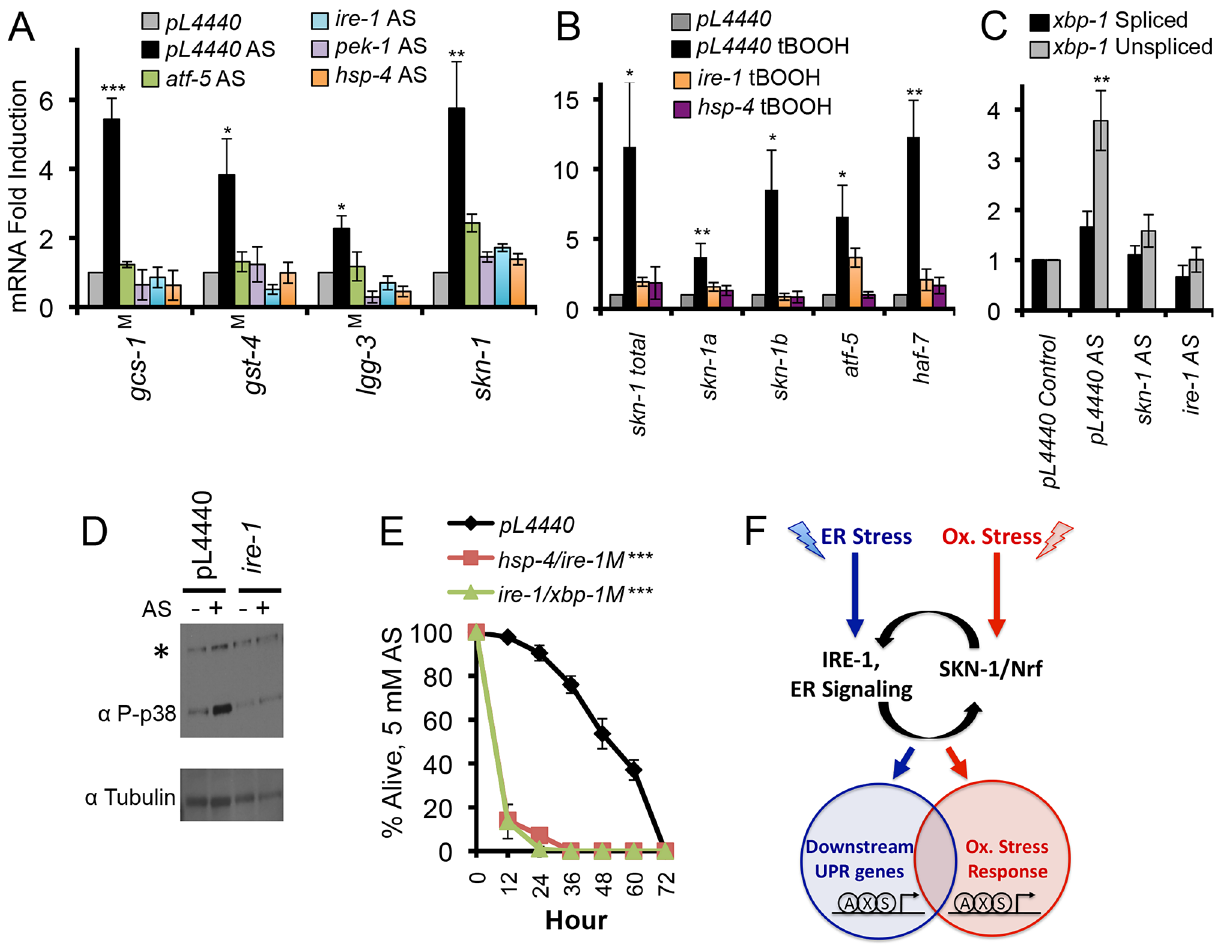
Figure 7. Dependence of oxidative stress responses on UPR components. (A, B) Importance of core UPR genes for SKN-1-mediated oxidative stress responses. Induction of skn-1 and skn-1 target gene transcription by AS (A) or t-BOOH (B) was impaired by RNAi against core UPR genes or in core UPR factor mutants (indicated by M ). qRT-PCR was performed after treatment with 5 mM AS for 1 hour, or 12 mM t-BOOH for 1 hour. (C) Accumulation of xbp-1 mRNA in response to AS-induced oxidative stress. Note the predominant increase in the unspliced form. (D) Dependence of AS-induced p38 phosphorylation on ire-1 . Phosphorylated (active) p38 was assayed by phospho-specific antibody as in [38], and ire-1 expression was knocked down by RNAi. *background signal. (E) UPR factors are required for oxidative stress defense. Survival of AS treatment (5 mM) was scored in RNAi Control, hsp-4(RNAi)/ire-1(zc14) , and ire-1(RNAi)/xbp-1(SJ17) animals (M indicates mutant). Error bars represent SEM, and * p # .05, ** p # .01, *** p # .001, relative to pL4440 Control calculated using student’s t-test. (F) Functional integration of the ER and oxidative stress responses through SKN-1 and canonical UPR components (see text). SKN-1 is essential for the UPR because it directly controls transcription of most UPR signaling and transcription factors. These UPR factors in turn regulate SKN-1 expression, and function in concert with SKN-1 at downstream targets. This is shown arbitrarily as SKN-1 (S) binding to target promoters together with XBP-1 (X) and ATF- 6 (A). SKN-1 and mammalian Nrf proteins are present in the ER, suggesting a possible signaling role. UPR factors are required not only for SKN-1 to function in the context of the UPR, but also for SKN-1 to mobilize distinct oxidative stress responses. See also Figure S7 and Table S4.